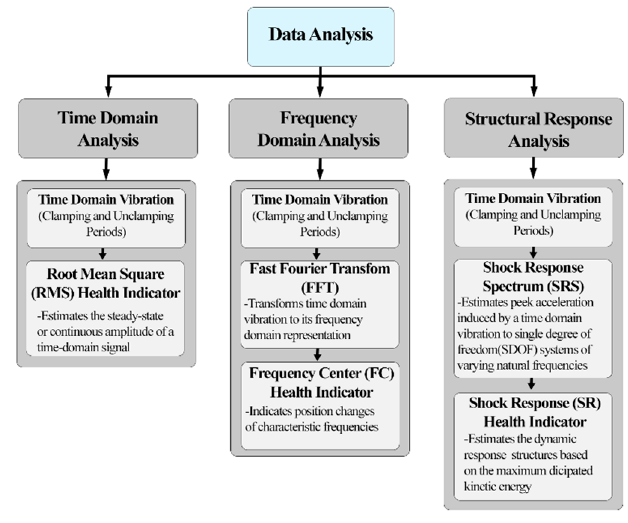
Figure 4. Flowchart of the data analysis procedure.